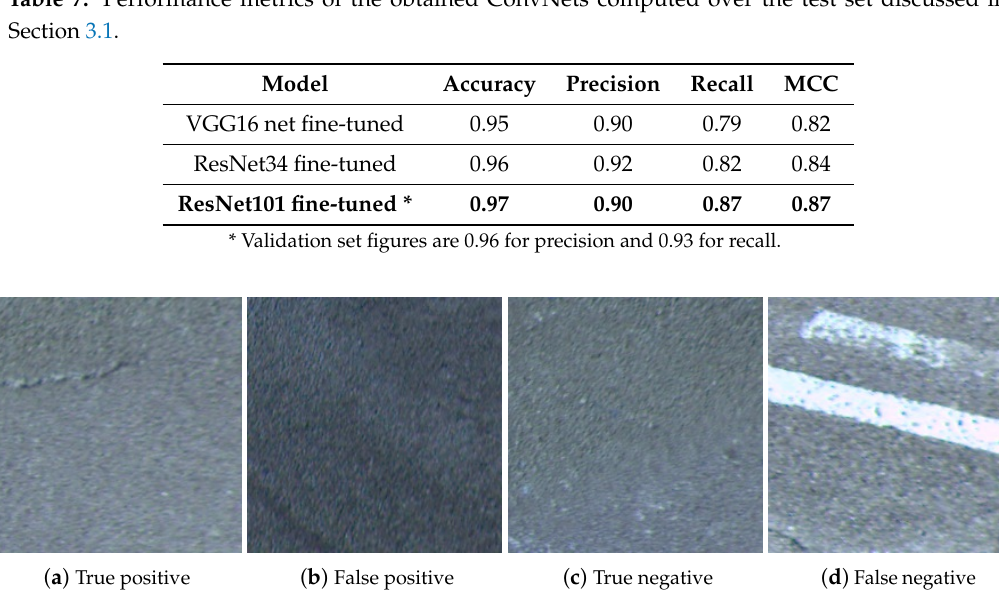
Figure 10. A selection of outputs from the ResNet101